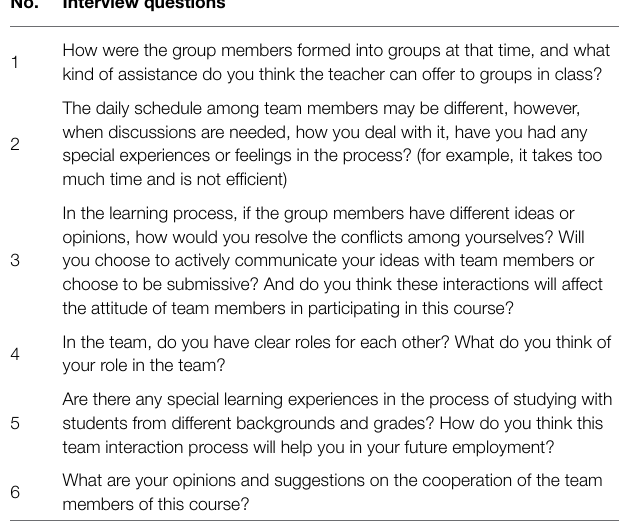
TABLE 4 | Interview